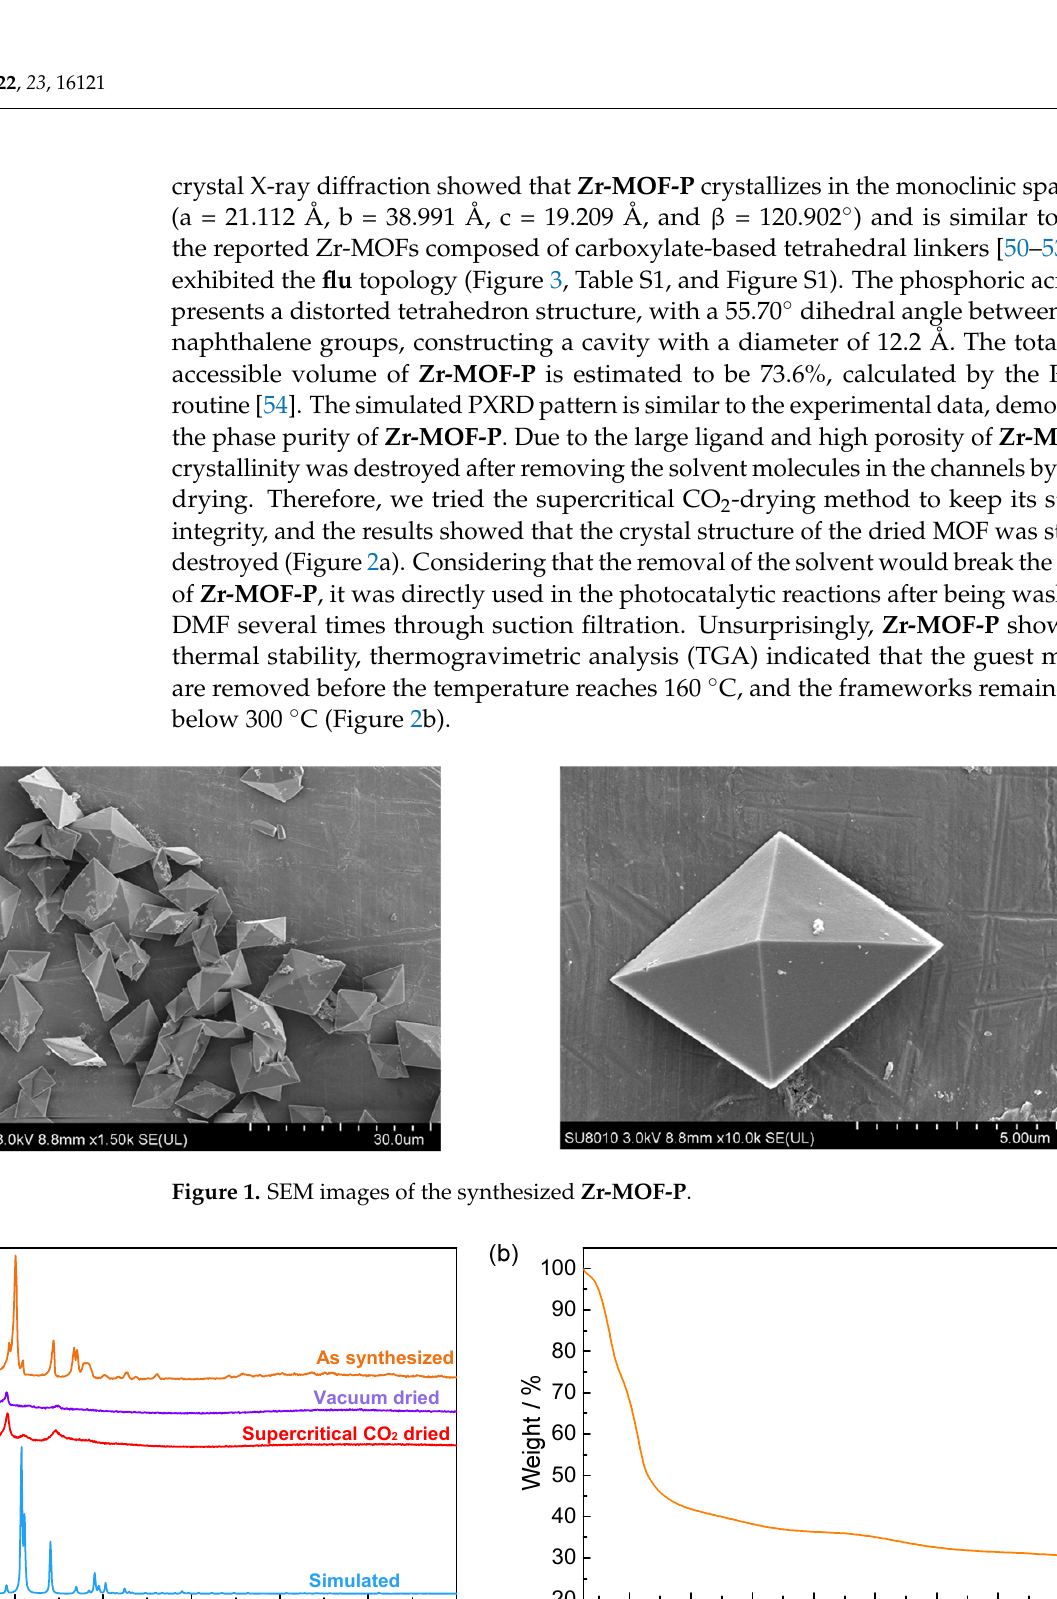
Figure 3. ( a ) Structure of Zr-MOF-P . C, gray; O, red; P, pink; Zr, cyan polyhedra; the yellow sphere is the cavity; H atoms are omitted for clarity. ( b ) The flu topology of Zr-MOF-P . The orange and cyan polyhedra represent 4- and 8-connected nodes, respectively.